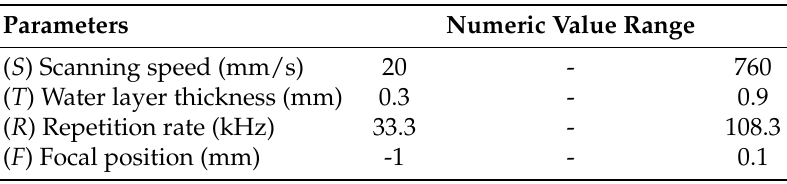
Table 2. Final optimization parameter range and values.